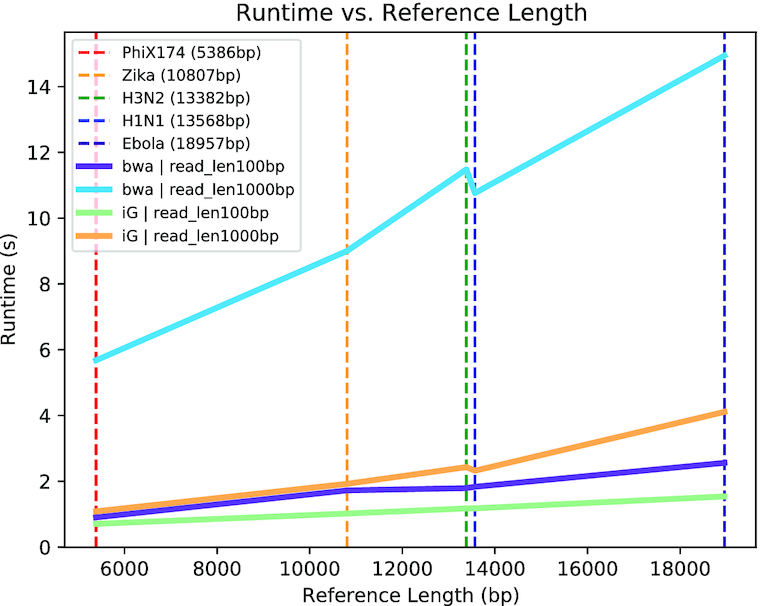
Runtimes for simulated reads from 5 reference genomes. The datasets consisted of reads averaging 100× coverage and a reference file. Each dataset was tested, defined as aligning then variant calling, using iGenomics running on an iPhone and a BWA/SAMtools pipeline running on a laptop. The technical specifications of the iPhone and laptop used for testing are described in the Results section. Each trend line indicates the runtime for each dataset using the denoted alignment and analysis software; iG indicates iGenomics and bwa indicates the BWA/SAMtools pipeline. The dotted lines indicate the specific measurements recorded.